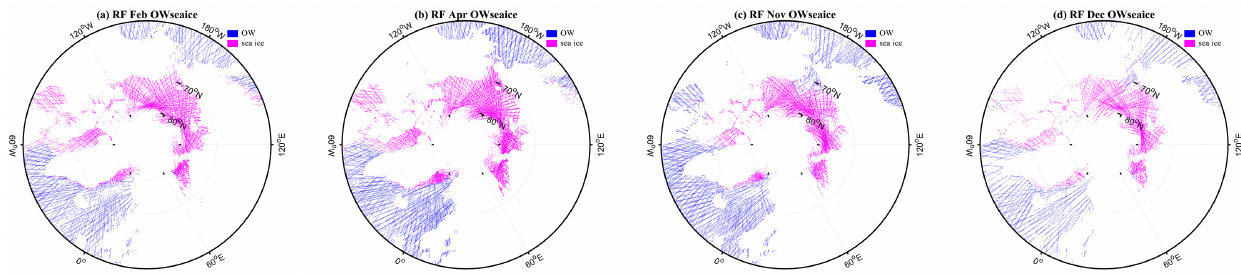
Figure A2. RF for OW-sea ice classification using the data in March as the training set. The data in ( a ) February, ( b ) April, ( c ) November, and ( d ) December are used as the test set in turn.